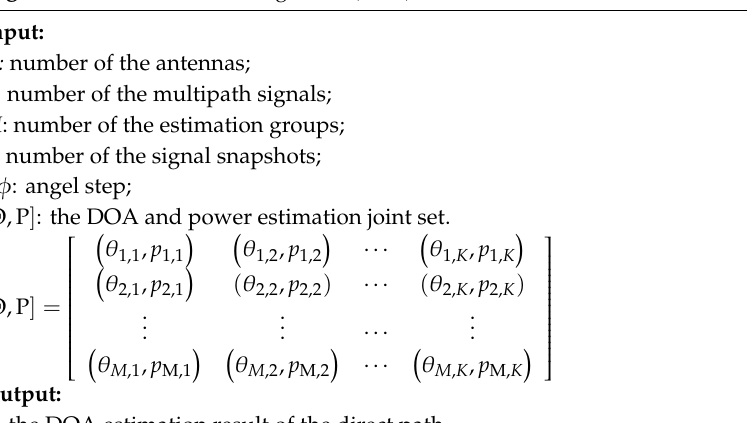
Algorithm 1 Direct Path Recognition (DPR)